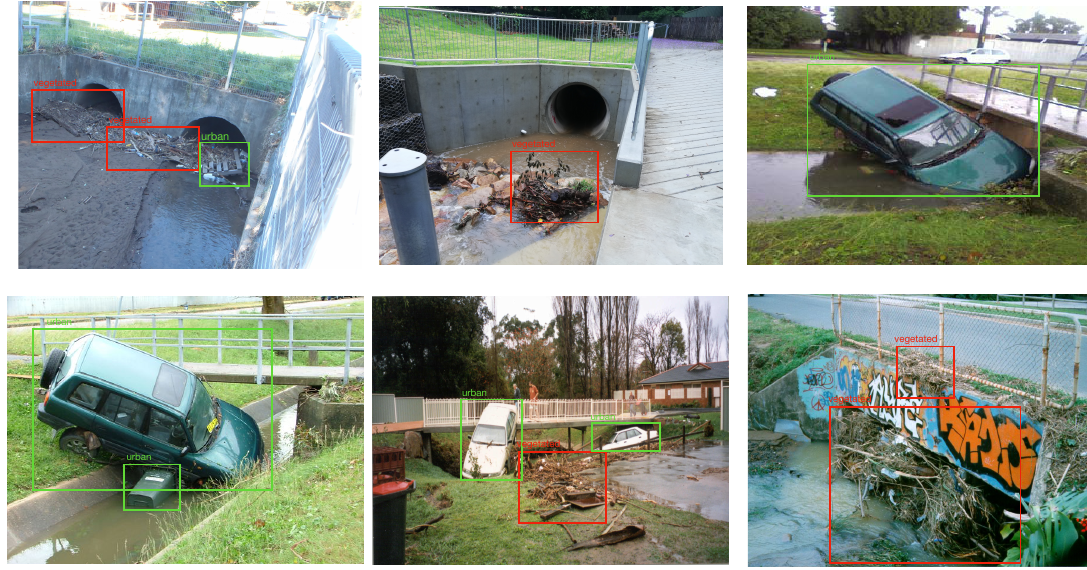
Figure 1. Annotated Real Samples from FORD.